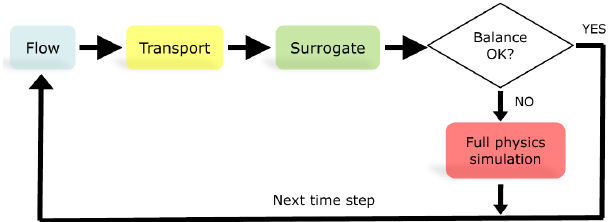
Figure 1. Schematic view of hierarchical sequential non-iterative coupling. The decision on whether or not to accept the predictions of a multiple multivariate surrogate is based on computing the mass balances for the three elements forming dolomite and calcite before and after reaction and computing their mean absolute error. If this error exceeds a given threshold, the more expensive equation-based geochemical simulator is run